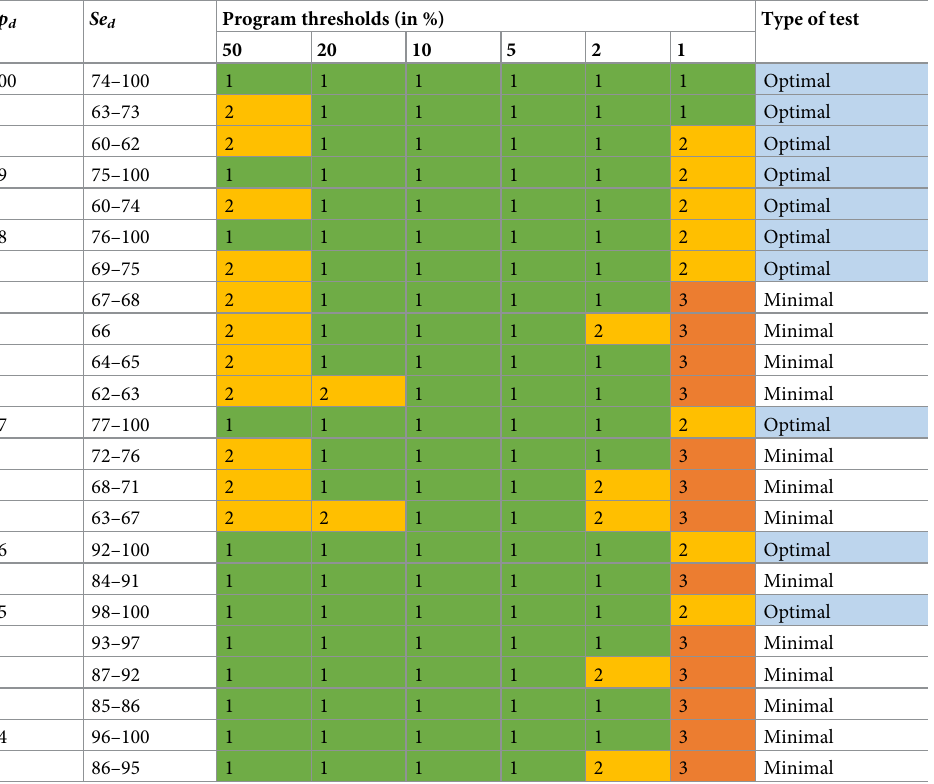
decision making ( ε overtreat � 25% and ε undertreat � 5%) for each of the 207 pairs of sensitivity ( Se d ) and specificity ( Sp d ). For simplicity, we have classified the width of the grey zone into three levels (1–3) for each threshold and ε arately. This classification into 3 levels was based on the 25 th and 75 th percentile of the width of the grey zones (level 1: width of grey zone < 25 th percentile; level 2: 75 th percentile > width of grey zone � 25 th percentile; level 3: width of grey zone � 75 th percentile (see S1 Table ) across all potential diagnostic methods that allowed for adequate program decision making. In other words, each of these diagnostic methods allowed for adequate decision making ( ε set at 25%) at a true underlying prevalence of zero. Diagnostic tests were considered ‘optimal’ (blue) when they resulted in level 1 grey zone in at least 3 out of the 6 thresholds and did not result in a level 3 grey zone in any of the 6 program thresholds. In all other cases, the diagnostic test was considered ‘minimal’